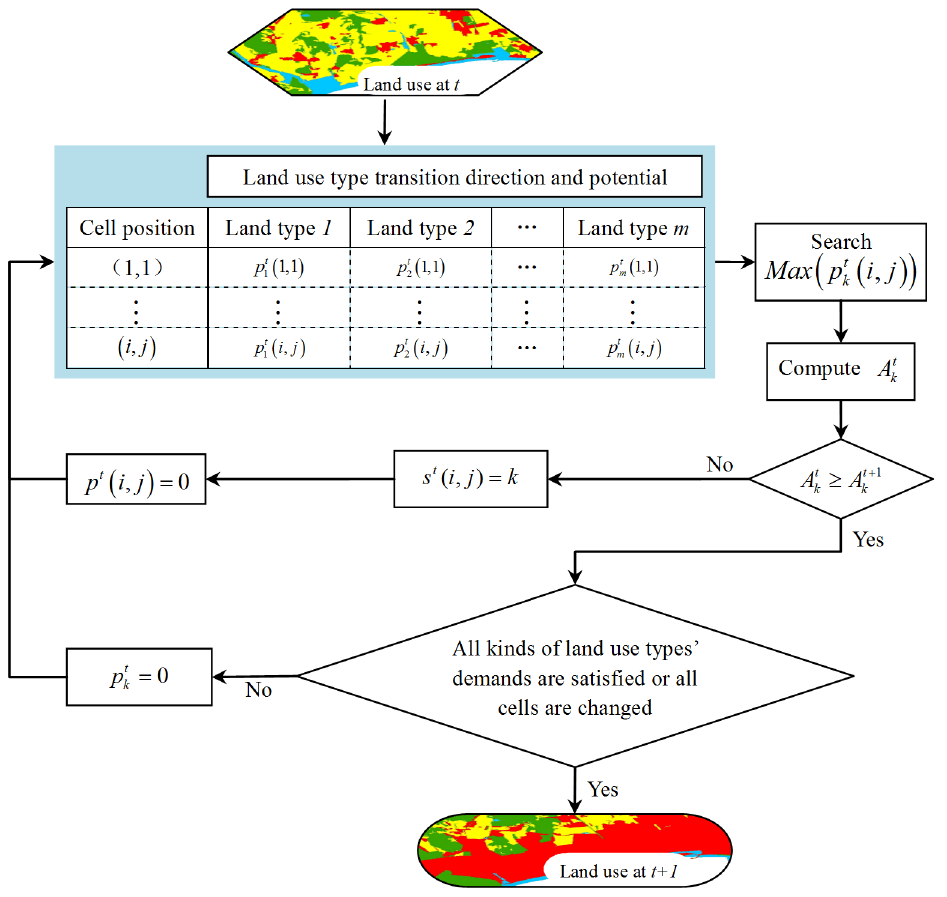
Figure 3. Flow chart of multi-target land use competition allocation algorithm.